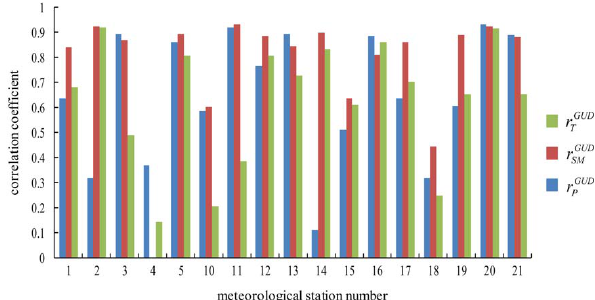
Fig. 11. Correlation coefficients between NDVI-derived GUD (Green-up Onset Date) and regressed GUD s by assuming different dominant indices among the meteorological stations, green represents the assumption of temperature as dominant control, red and blue represent that of soil moisture and precipitation respectively.